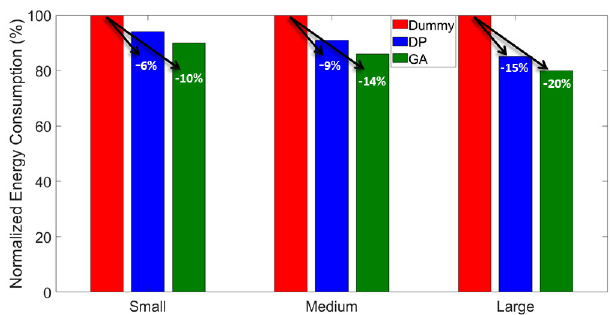
Figure 9. The normalized energy consumption with respect to different approaches under different scenarios when the scenario gets bigger, as a result of more overall energy demand for coverage and service. For all scenarios, the DP implementation causes a less number of replenishment compared to the dummy strategy, and the decrease is reached to 11% in the large scenario.